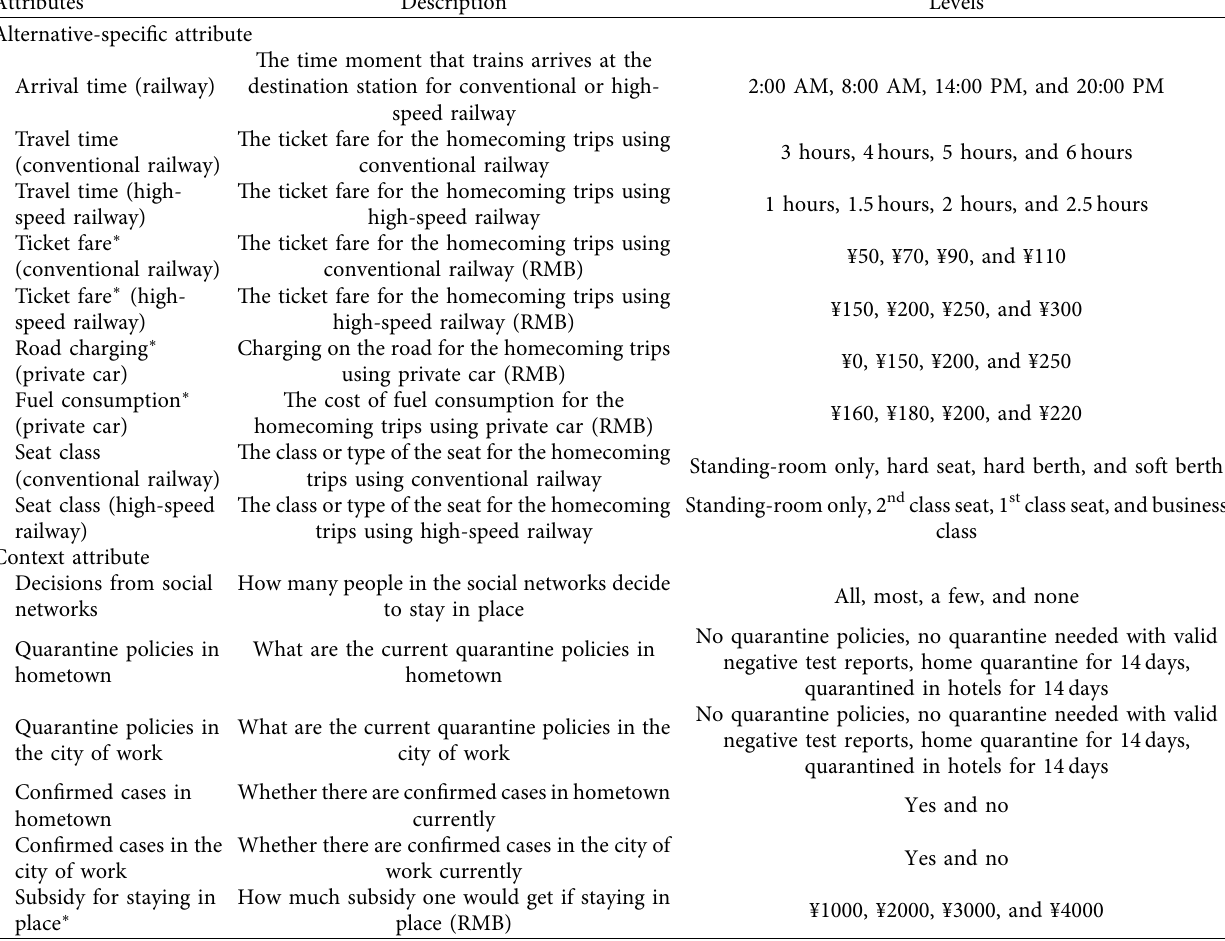
Table 1: Attributes and corresponding